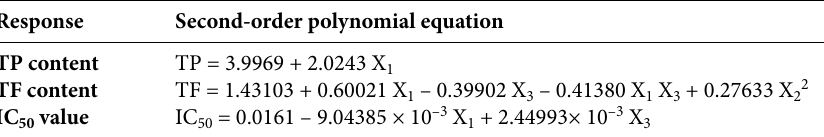
Table 5. Model equations which are able to predict response values within investigated experimental domain